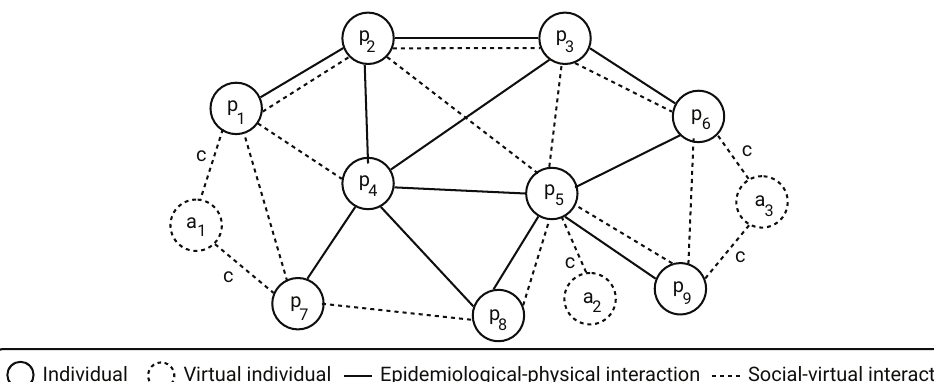
Figure 3. Schematic view of the model with both individuals in the populations and virtual individu- als set by a CP to influence on the PIPs the population